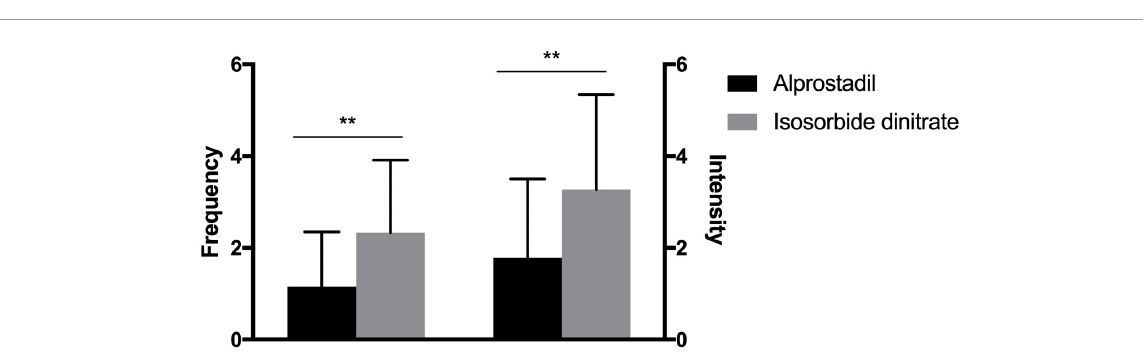
Frontiers in Cardiovascular